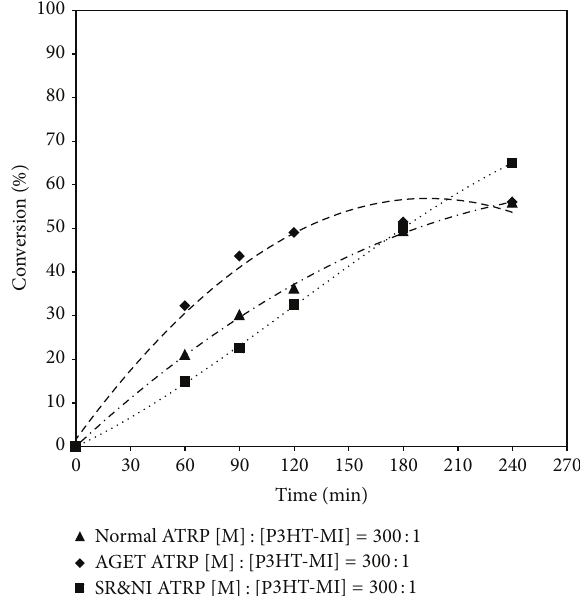
Figure 10: Relationships between monomer conversion and reac- tion time during polymerisations of styrene and chloromethyl- styrene via different ATRP systems.